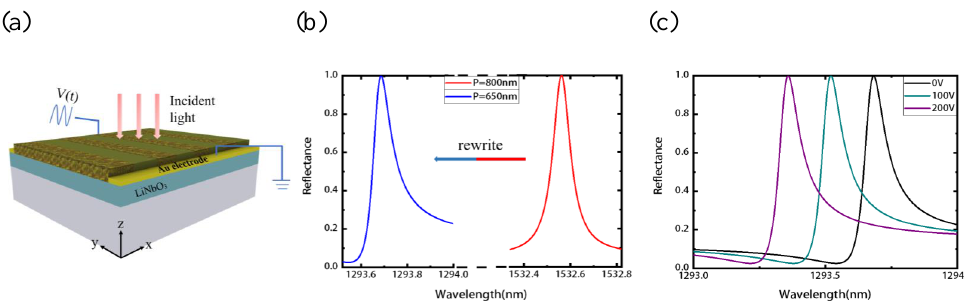
Figure 5. The electro-optical tunability of the resonant Sb 2 S 3 -LN metasurface. ( a ) The schematic of the resonant metasurface with a pair of Au electrodes. ( b ) The phase change reconfiguration of the resonant metasurface. As the grating period rewritten from P = 800 nm to P = 650 nm, the resonant wavelength shifts from 1532.564 nm to 1293.682 nm. ( c ) The reflection spectra vary with different gate voltage. As the voltage adds from 0 V to 200 V, the resonant wavelength shifts from 1293.682 nm to 1293.358